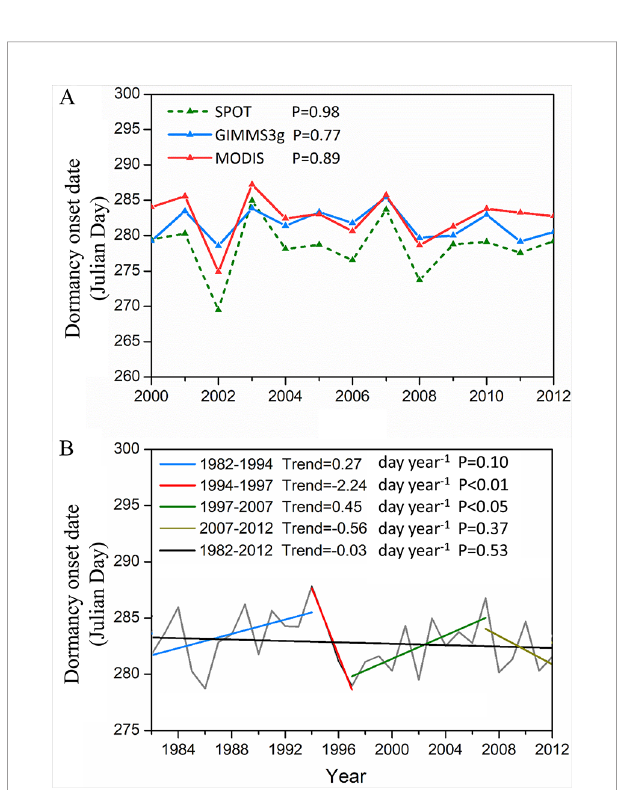
FIGURE 4 | Interannual variations in vegetation DOD. (A) Interannual changes in the two methods averaged DOD derived from the GIMMS3g, MODIS, and SPOT NDVI during 2000 – 2012, respectively. (B) Interannual change in two methods averaged DOD derived from the GIMMS3g NDVI. The turning points in the DOD trends (GIMMS3g 1982 – 2012) determined by the Mann – Kendall test are the years of 1994, 1997, and